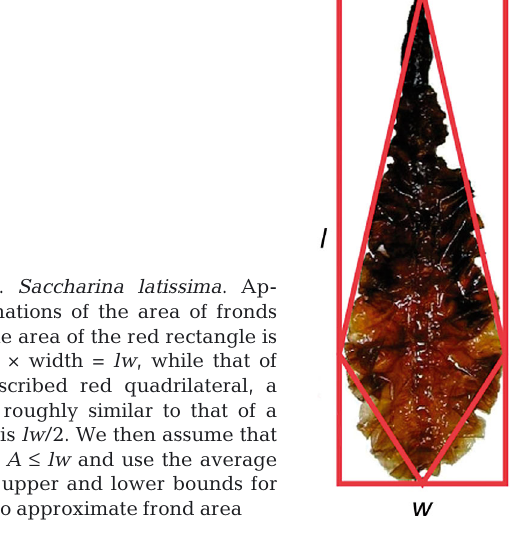
Table 1. Salmo salar . Corrected monthly salmon production and dissolved inorganic nitrogen (NH 4+ -N) (both in t) released from the AquaCulture Engineering salmon farm from June 2010 to June